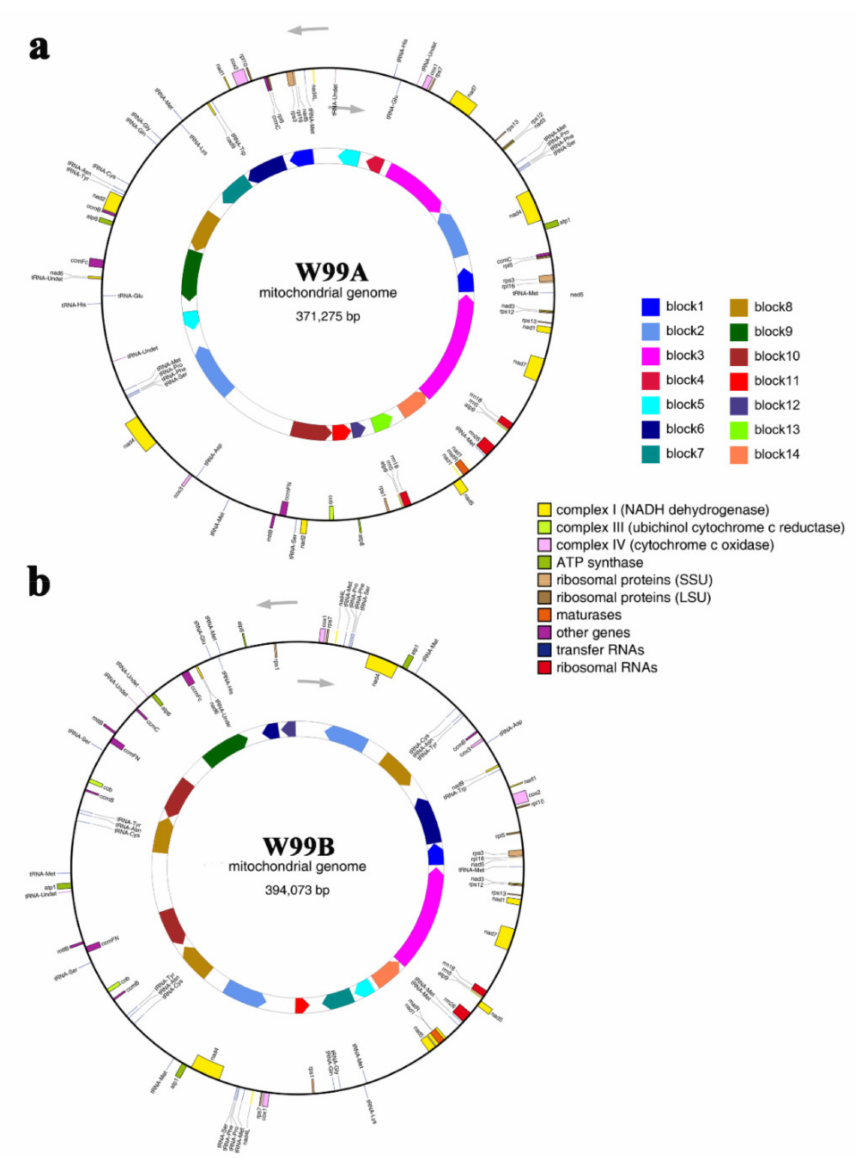
Figure 3. Mitochondrial genome maps of the celery CMS line W99A ( a ) and its maintainer line W99B ( b ). Genes names inside and outside of the circle indicate clockwise and counterclockwise transcription, respectively. Different colours indicate different functions of gene products. The inner circles indicates syntenic sequence